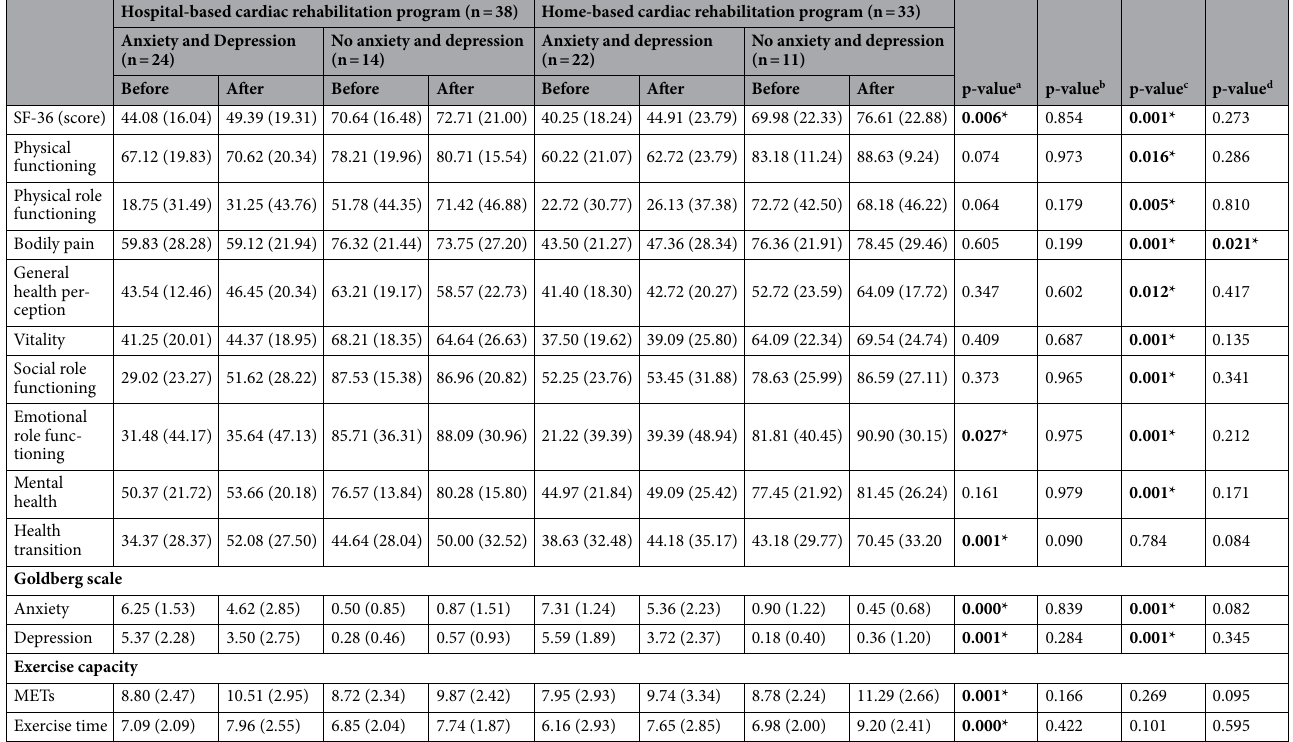
Table 2. Results obtained in quality of life, levels of anxiety and depression and physical capacity before and after the two different cardiac rehabilitation programs considering symptoms of anxiety and depression. Data are presented as mean values (SD). *Significance level p < 0.05. Significant values are highlighted in bold. a Significance level for the hypothesis of no time effect. b Significance level for the hypothesis of no time x program effect. c Significance level for the hypothesis of no time x group effect. d Significance level for the hypothesis of no time x group x program